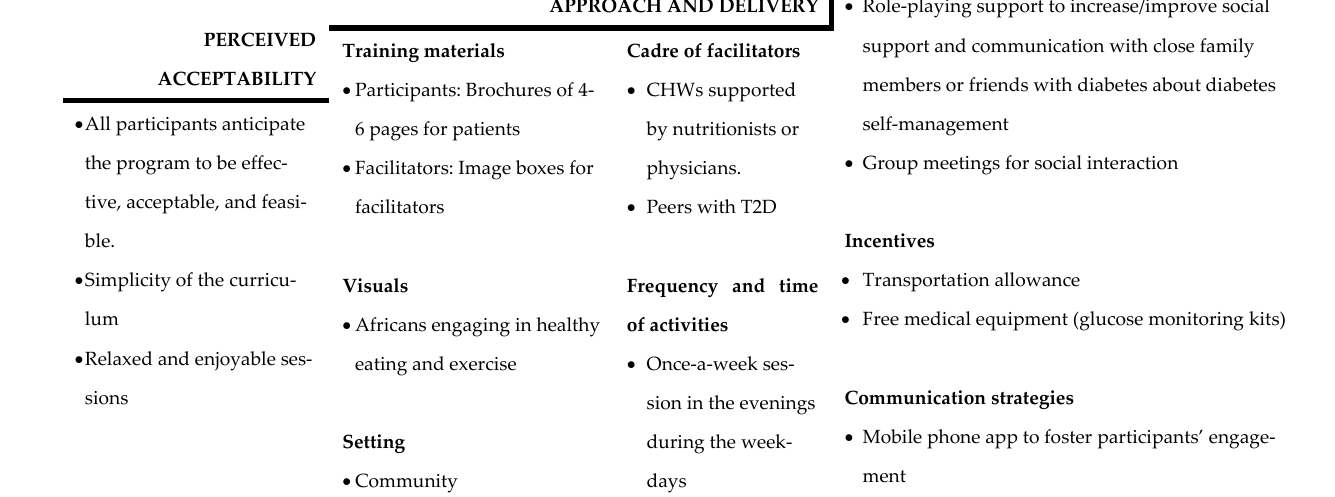
Figure 1. Summary of findings.